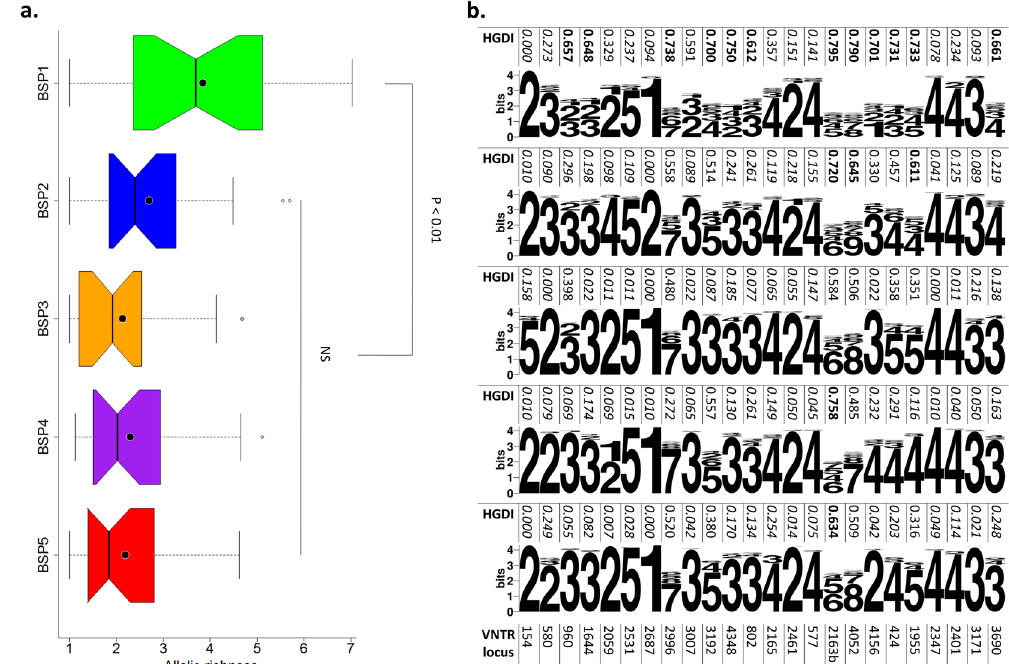
Figure 2. The mean allelic richness of 24-loci MIRU-VNTRs and WebLogo representation to visualize main patterns observed for BSPs. ( a ) Allelic richness of different BSPs. Notched boxes correspond to median values ± quartiles of allelic richness, while the dots and bars within notched boxes correspond to the mean and median values. Dotted lines adjacent to the boxes show the minimum/maximum values. Note that comparison tests as well as P values were estimated based on mean values by t-test. ( b ) WebLogo of allele copy number of 24-loci MIRU-VNTRs loci in each BSP grouping. The allelic diversity of the loci was classified as highly discriminant (HGDI > 0.6, bold in the table), moderately discriminant (0.3 ≤ HGDI ≤ 0.6, normal) and poorly discriminant (HGDI < 0.3,